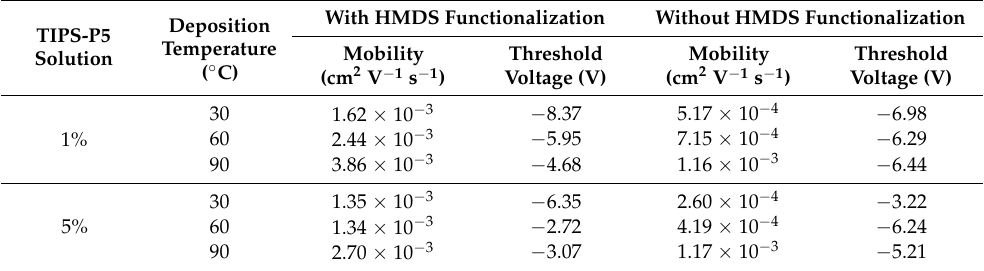
Table 1. BG-OFETs parameters extrapolated using Equation (1). All the reported values are averaged over 16 transistors.